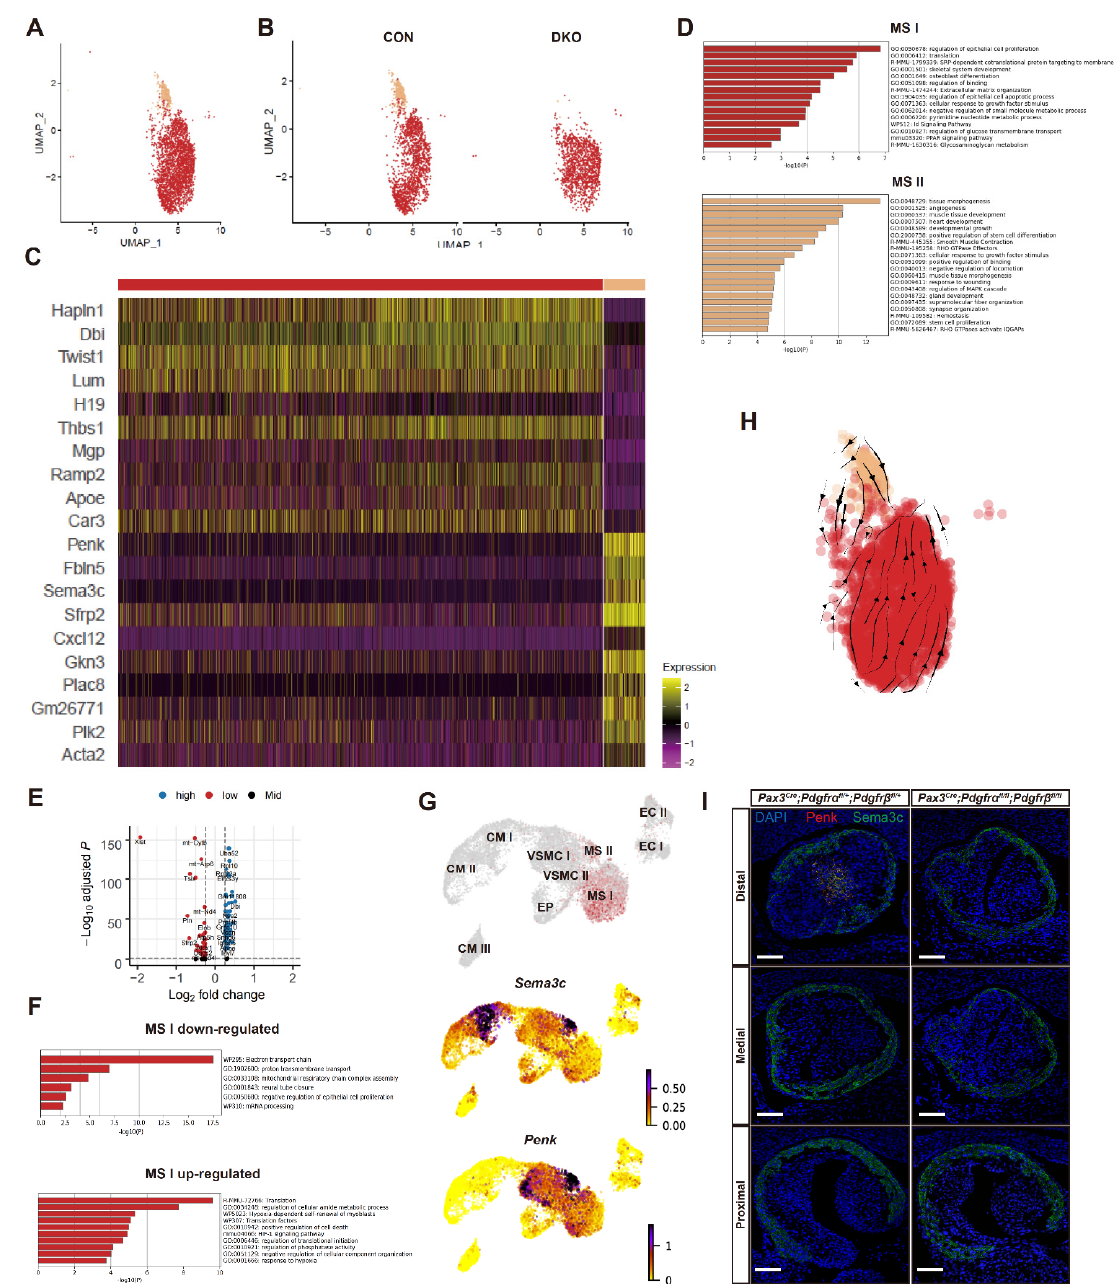
Figure 5. MS clusters and changes after PDGFR α and PDGFR β knockout. ( A ) UMAP plot of all captured MS populations colored by cluster identity (MS I and II). ( B ) Cell cluster distribution of the DKO and control group on UMAP plots revealed that cluster MS II was absent in the DKO group. ( C ) Heatmap showing DEGs between MS I and II. ( D ) Functional enrichment of genes significantly up-regulated in MS I and II. ( E ) DEGs of MS I after PDGFR α and PDGFR β DKO. ( F ) Functional enrichment of genes significantly up-regulated and down-regulated in MS I between the DKO and control group. ( G ) Sema3c and Penk were both highly expressed on MS II, indicating that MS II rep- resented the MSs of the septal bridge in OFT. ( H ) Direction and rate of cellular state changes inferred